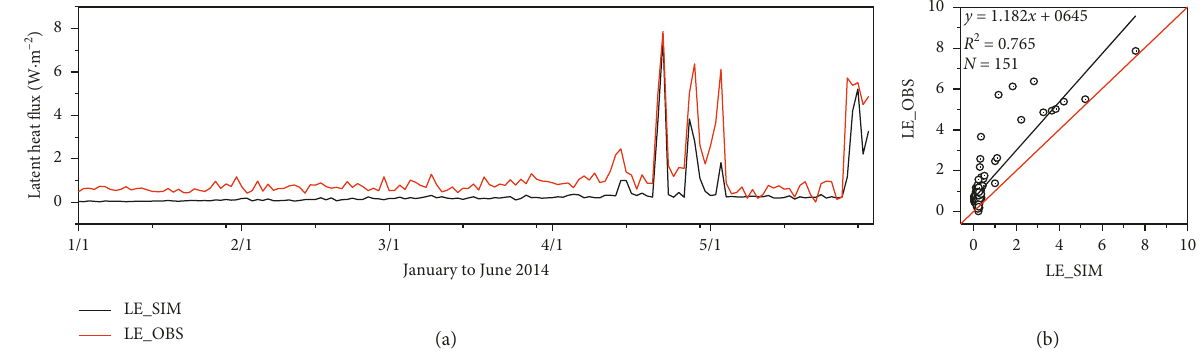
Figure 7: Contrast curve (a) and scatter plot (b) of the simulated (black) and observed (red) latent heat flux (LE) at the Tazhong station from January to June 2014.